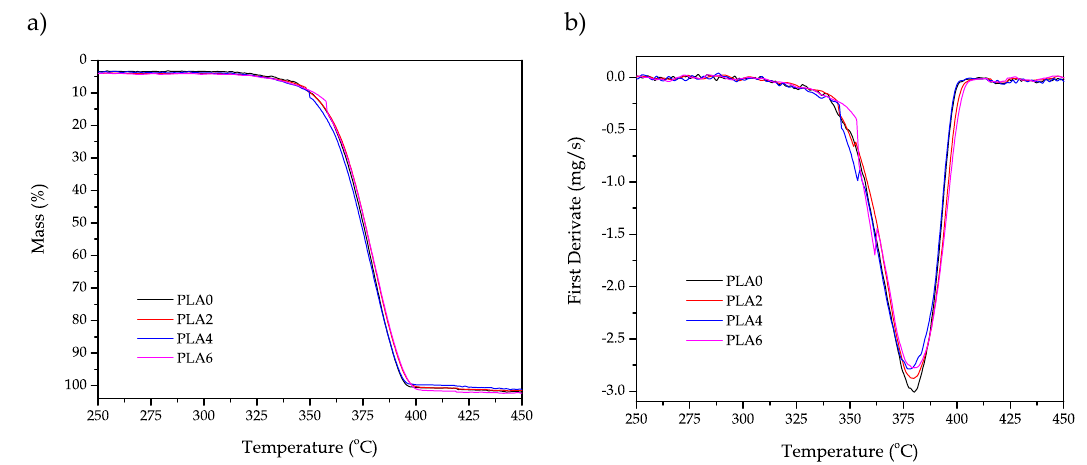
Figure 5. ( a ) Thermogravimetric analysis (TGA) and ( b ) first derivate thermogravimetric (DTG) curves corresponding to the injection-molded polylactide (PLA) pieces subjected to different reprocessing cycles.